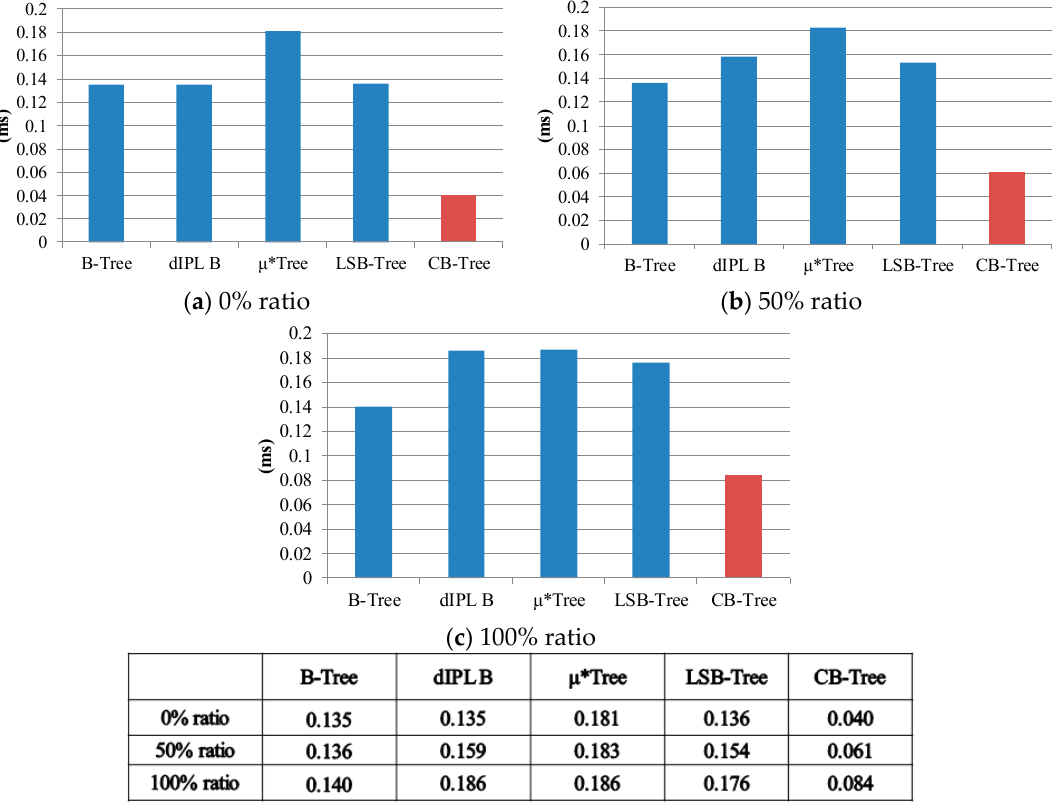
Figure 18. Average search time in structure-modified B-trees.